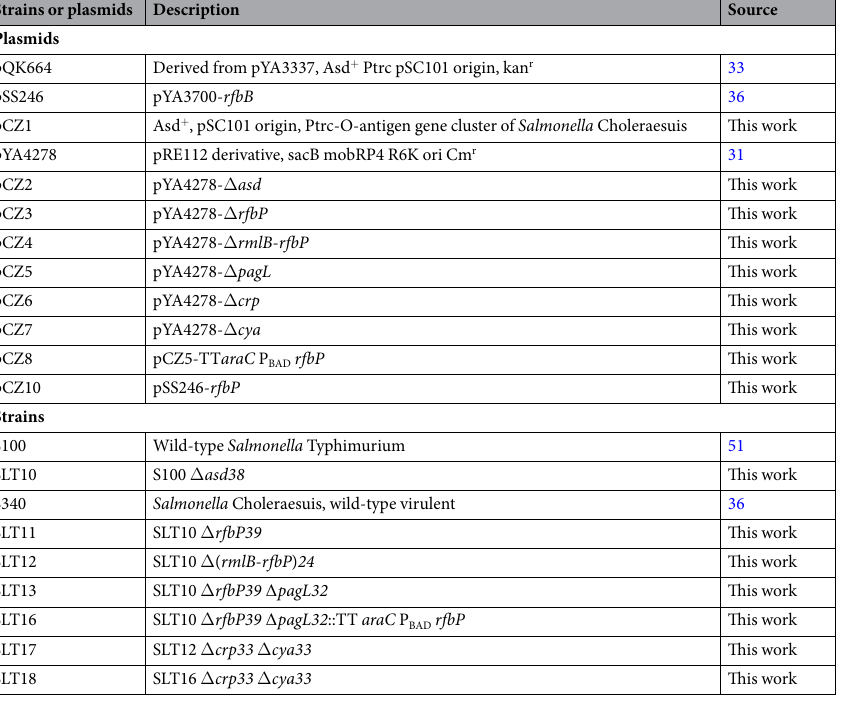
Table 1. Bacterial strains and plasmids used in this